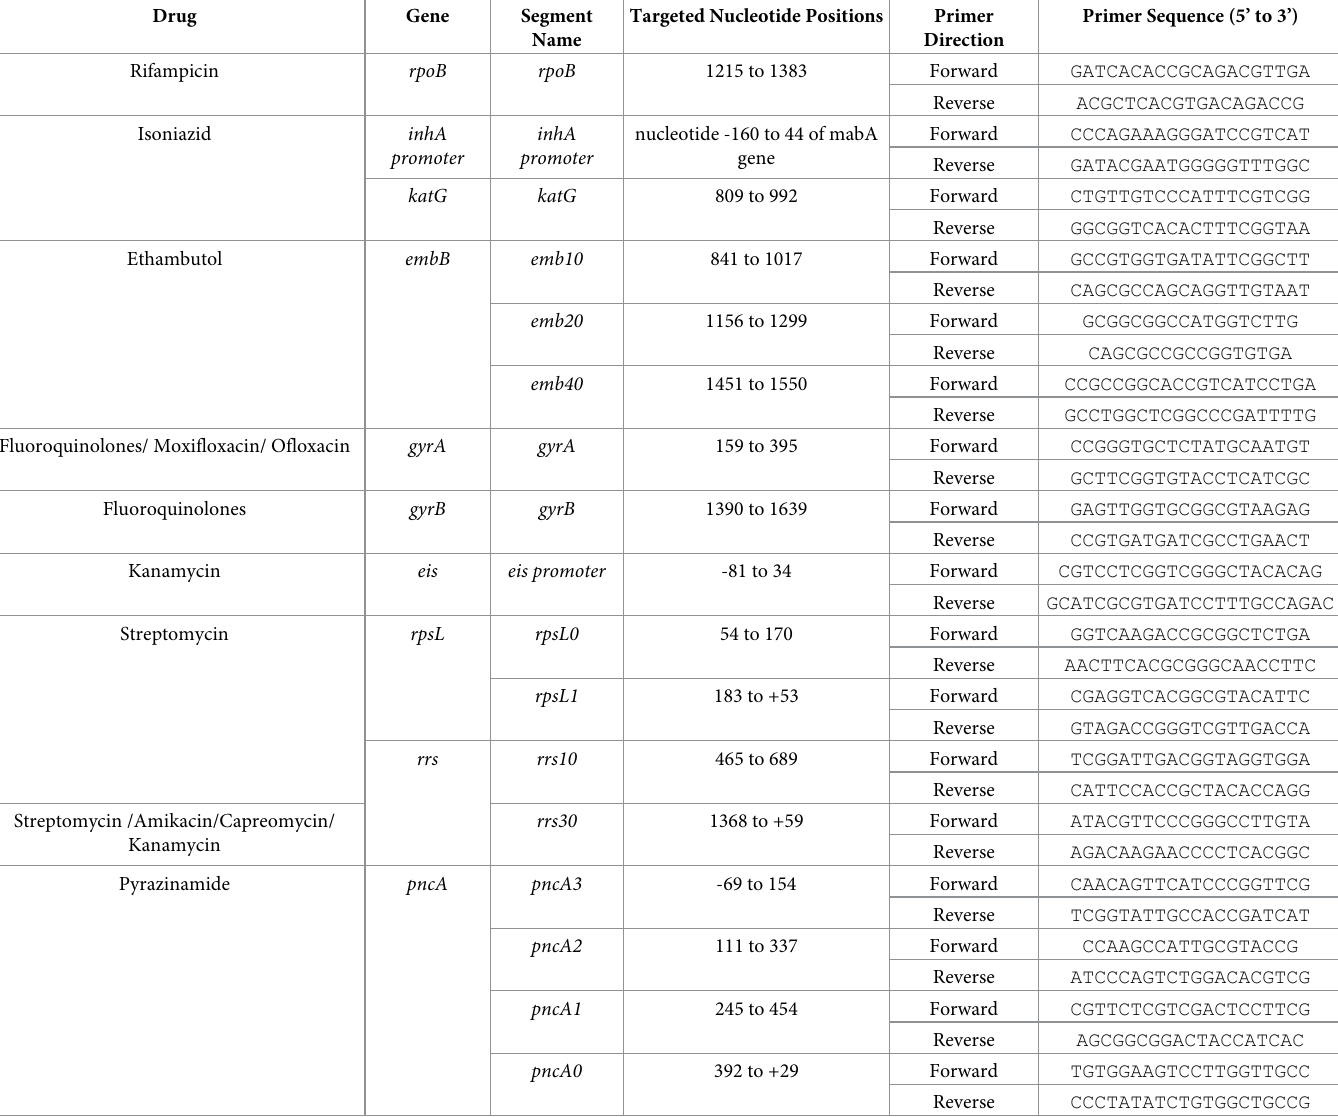
Table 1. Mycobacterium tuberculosis gene regions targeted for detection of drug resistance associated mutations and associated primers. Drug